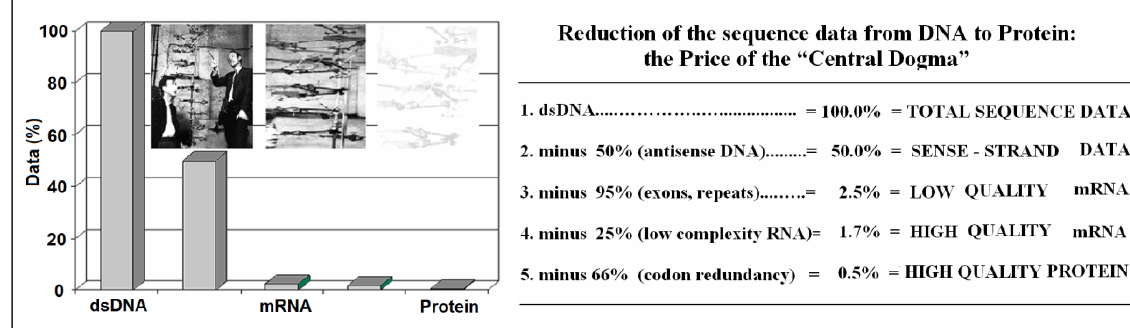
Figure 11. Reduction of the Sequence Data from RNA to Protein: The Price of the “Central Dogma”. There are 3 × 10 9 base pairs in the human genome (100% data), but only a tiny fraction (0.5%) are needed for protein synthesis. The three inserted pictures illustrate the catastrophic loss of meaning (information) when the number of pixels is reduced from 100 to 2.5% and finally to